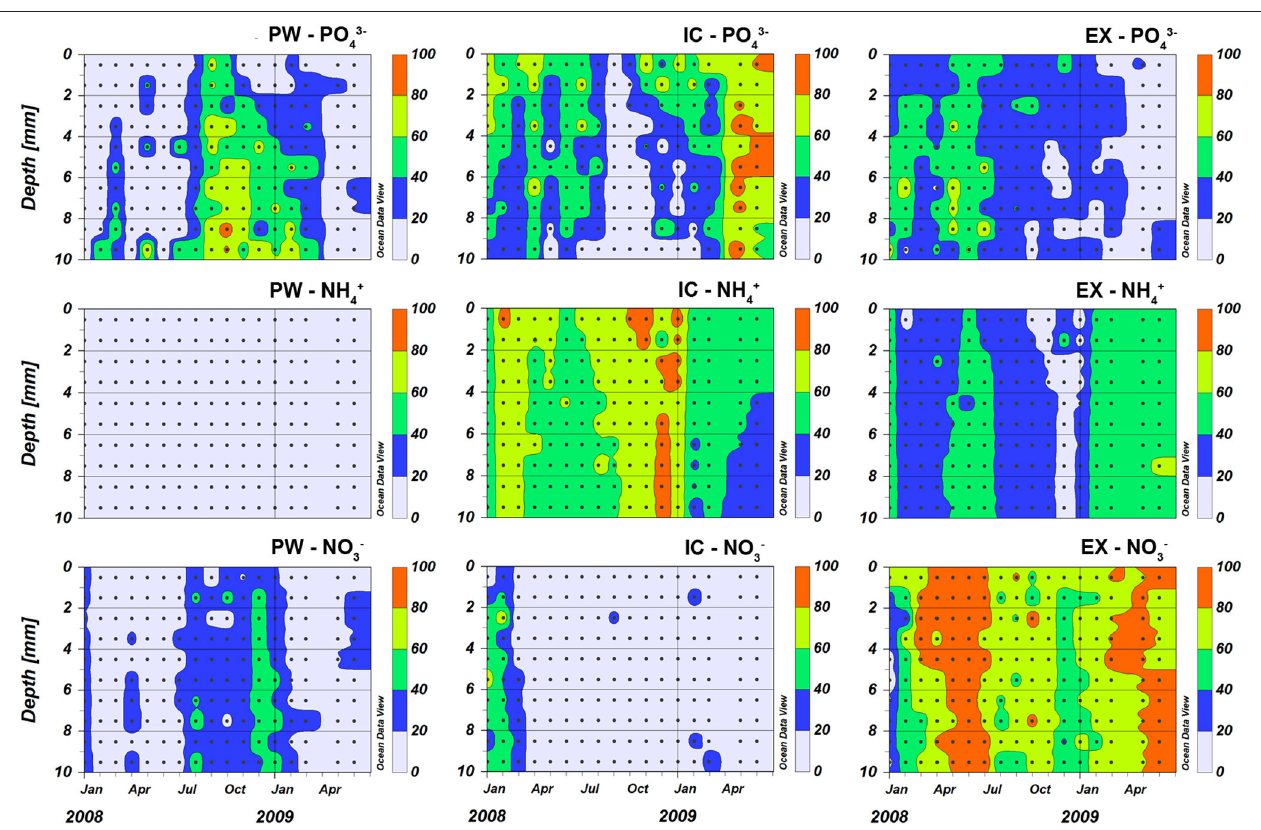
FIGURE 4 | Nutrient pools content in the porewater (PW), intracellular (IC) and KCl exchangeable (EX) fractions expressed as percentage (%) of the total nutrient pool at the sampling station on Trocadero Island, Bay of Cádiz, from January 2008 to June 2009. In order to facilitate comparison the data were represented using a discrete color gradient with steps of